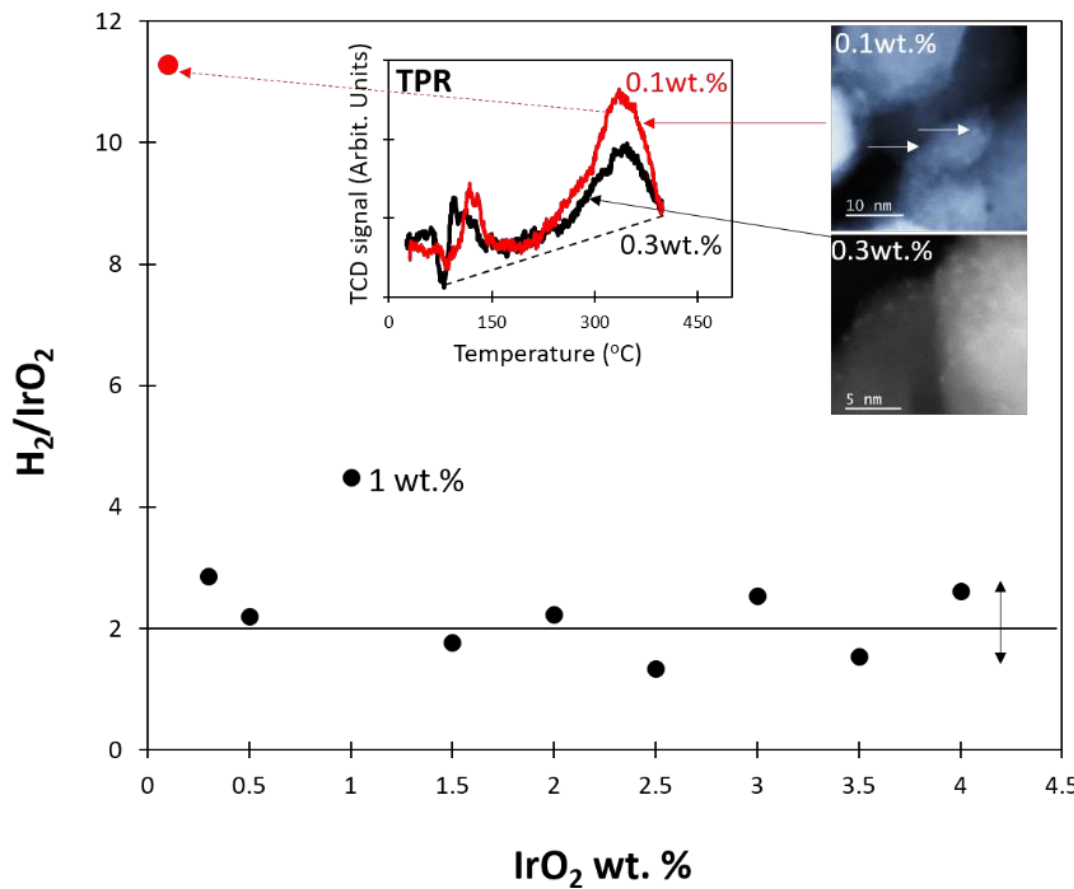
Figure 8. Quantitative analysis of the TPR series of IrO 2 /TiO 2 as a function of Ir wt.%. The Y-axis presents the H 2 /IrO 2 ratio. The dashed line indicates the expected ratio for a full reduction. The 0.1 wt.% profile is not included as quantification was not possible due to the low coverage. The 1 wt.% profile is also not included as it showed high deviation for the series (the H 2 to Ir ratio is found to be about 4). The particle size distribution and size of IrO 2 of these catalysts are given in Figures 1, 2 and 7.